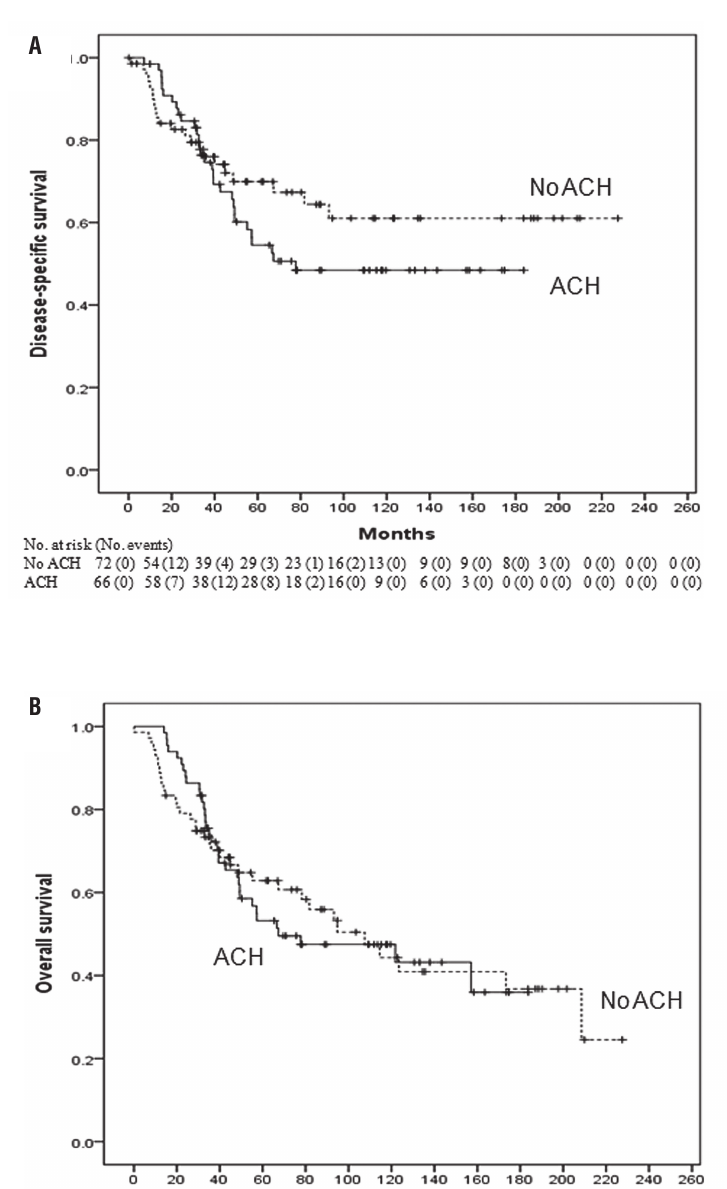
figure 2 - Kaplan-Meier analysis for (A) disease-specific survival and (B) overall survival after radical nephroureterectomy stratified by the administration of adjuvant chemotherapy in all